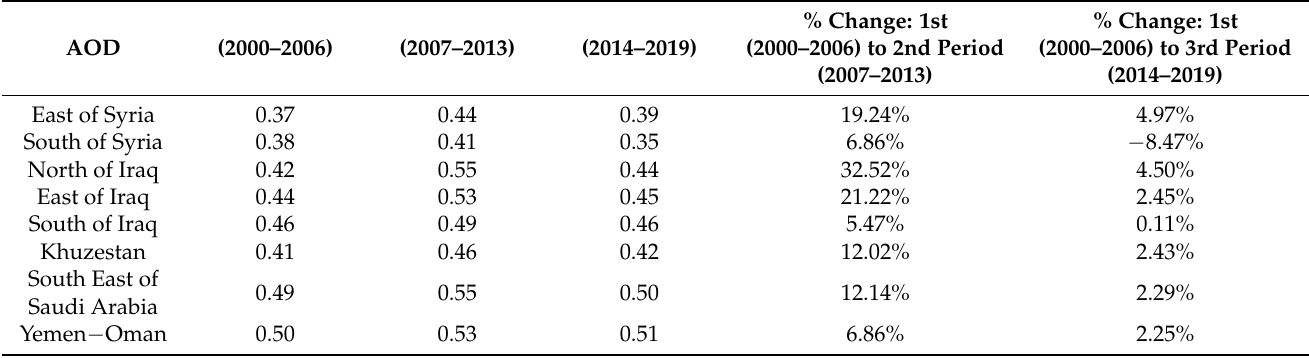
Table 1. Mean AOD for three periods (2000–2006, 2007–2013, 2014–2019) in different dust hotspot regions labeled in Figure 4 and the relative change between the 1st and subsequent